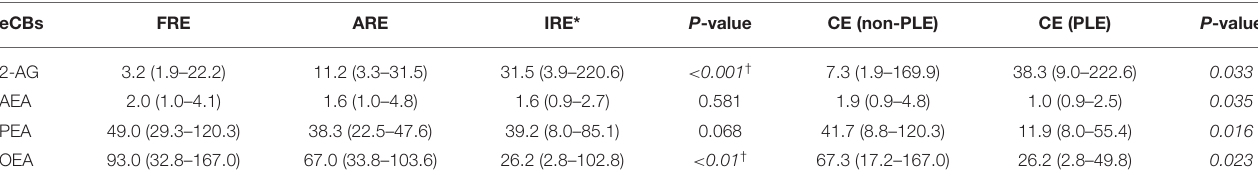
Median values, withminimum andmaximum inbrackets, ofplasma endocannabinoids (eCBs)indogswithchronicenteropathy with(PLE, n = 5)and without ProteinLosing Enteropathy (non-PLE, n = 28). CE, Chronic Enteropathy; 2-AG, 2-arachidonoylglycerol; AEA, N-arachidonoylethanolamine; PEA, palmitoylethanolamide; OEA, oleoylethanolamide. * IRE group includes five PLE dogs. † significant difference between IRE and FRE dogs. Italic denotes significance.